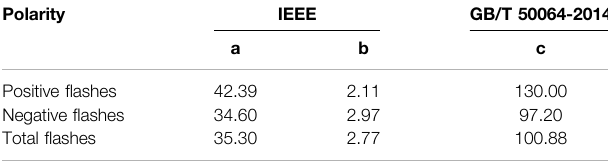
TABLE 2 | Fitting parameters recommended by the IEEE and GB/T 50064-2014. Polarity